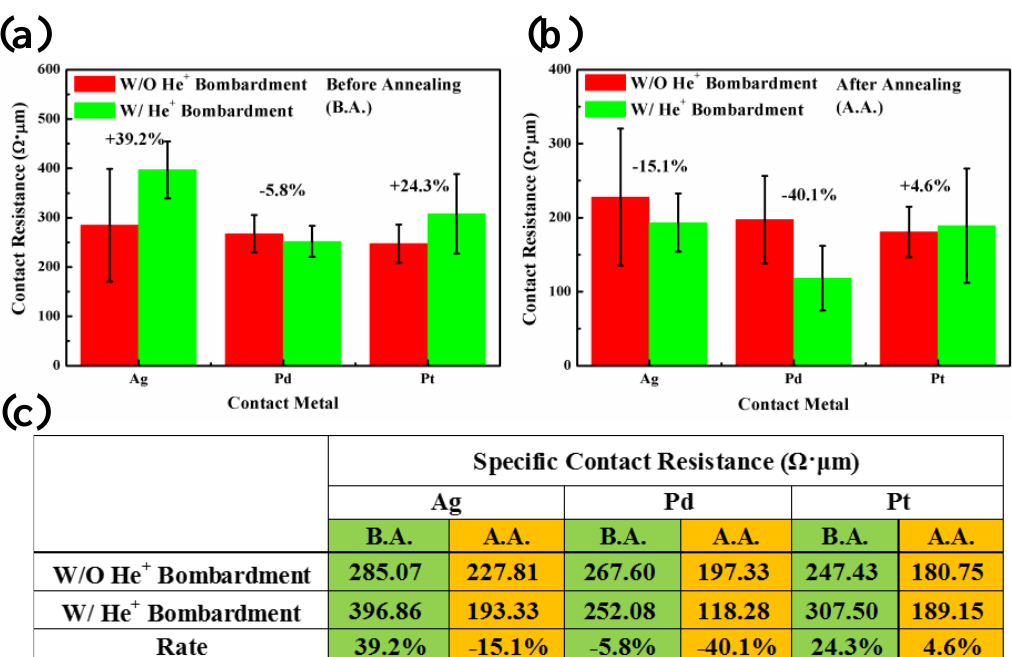
Figure 9. The comparison of R c for three G-M contacts with and without He + bombardment ( a ) before annealing and ( b ) after annealing; ( c ) Detailed R c values in ( a , b ) are summarized. B.A.: Before Annealing; A.A.: After Annealing.